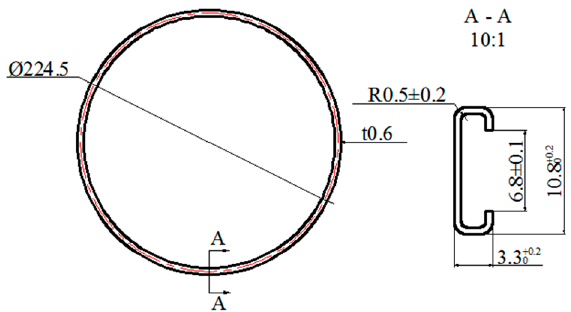
Figure 1. Concave ring.